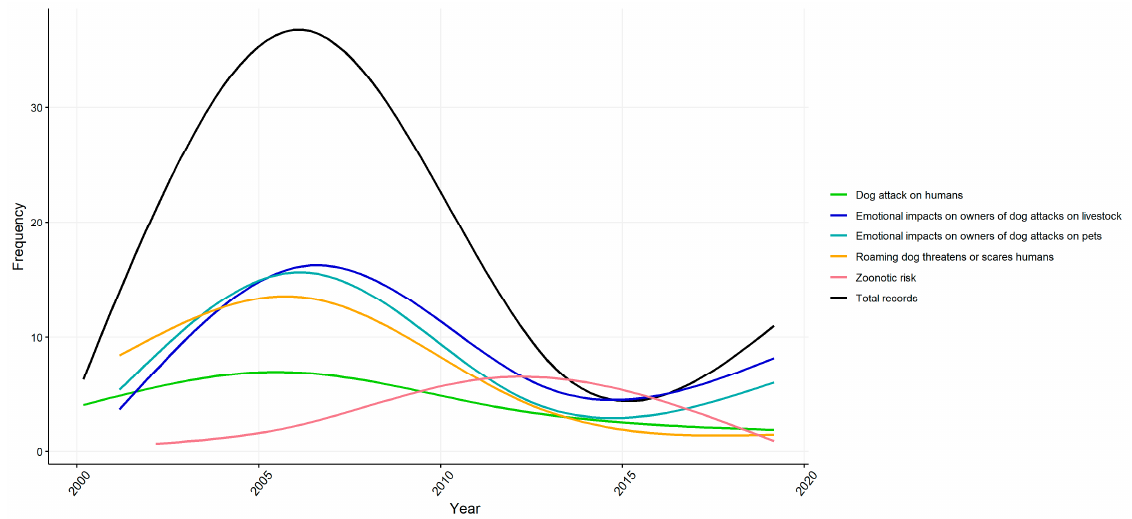
Figure 2. Frequency of articles (by reported impact) in a study of Australian news sources from 2000 to 2019. Lines are smoothed using a generalised linear model of article counts for each year in order to show the general trend during the study period.